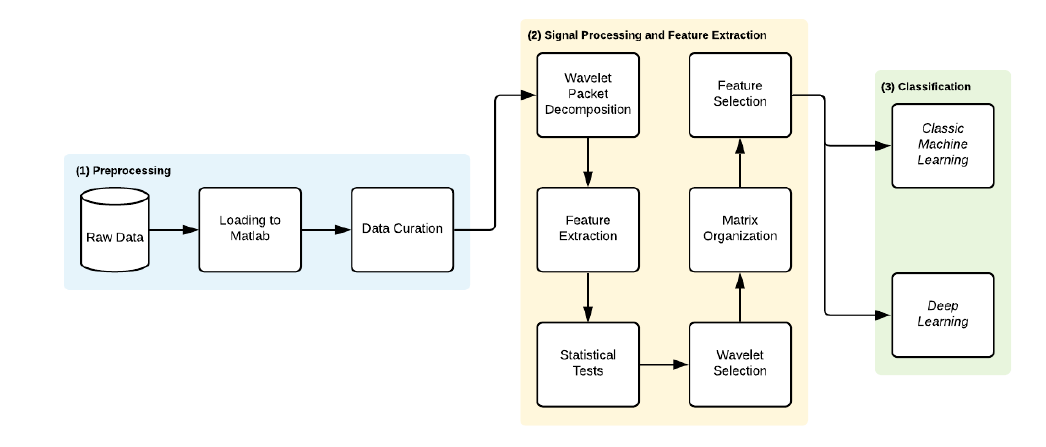
Figure 2. Methodology